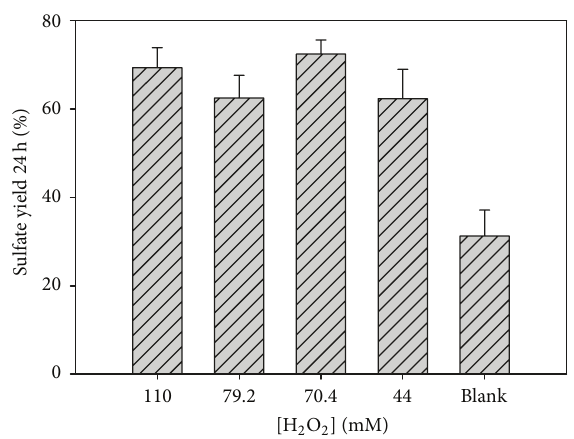
Figure 3: Sulfate yields obtained under PP-PVA-FeTFPP catalysis. Appropriate blank experiments were carried out in absence of hydrogenperoxide(Blankbarinthefigure).10mgofcatalystreacted inthepresenceof25 mMbuffersolutionpH5,10 mMNaHS,andthe Table1:Multicycleactivityofthesupportedmetalloporphine.10 mg of catalyst reacted in the presence of 25 mM buffer solution, 10mM